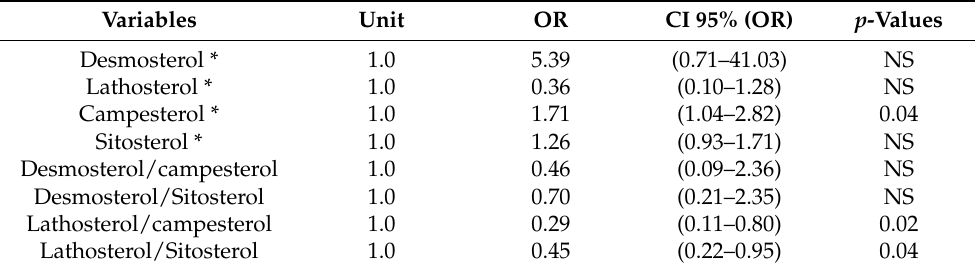
Table 5. Univariate logistic regression analyses for the presence of